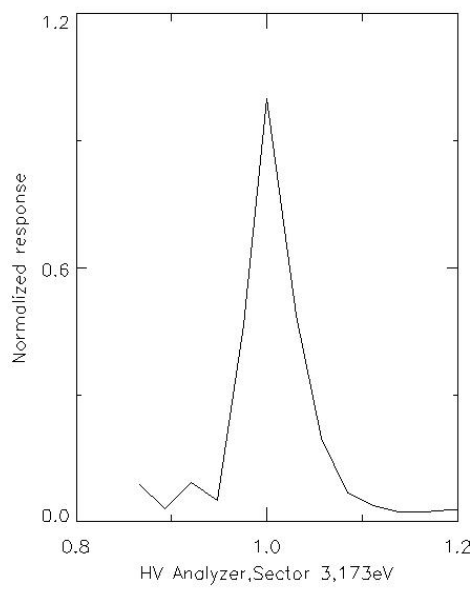
Fig. 6. Normalized energy response of Sector 3 at energy level of 173eV.